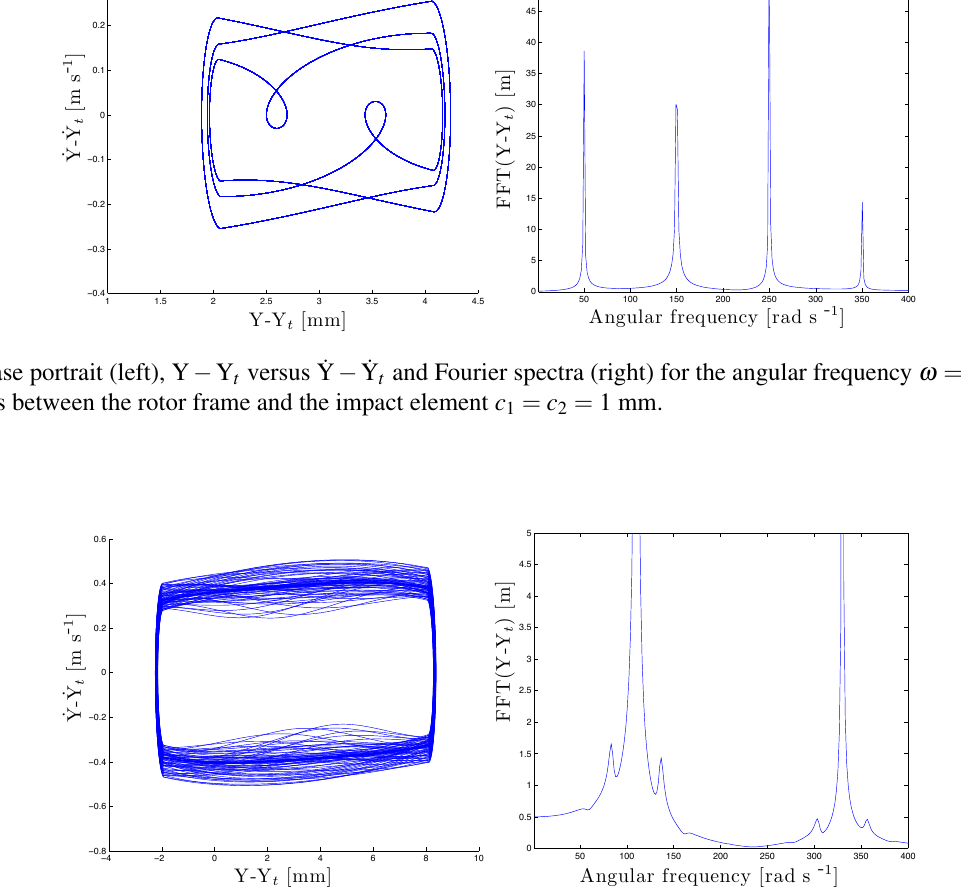
Fig. 17 Phase portrait (left), Y − Y t versus ˙Y − ˙Y t and Fourier spectra (right) for the angular frequency ω = 110 rad s − 1 and the gaps between the rotor frame and the impact element c 1 = c 2 = 5